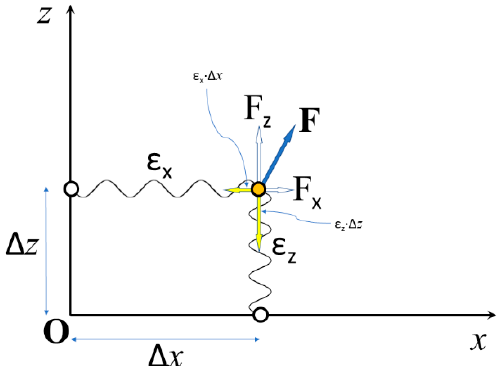
Figure A1. Schematic 2D representation of an elastic element with different stiffness values of ε x and ε z along the x and z directions, respectively. An external force F (blue arrow) applied to the tip of the elastic element (orange circle) is equilibrated by the strains Δ x and Δ z, eliciting the restoring forces (yellow arrows) that balance the component of F along the x (F x ) and z (F z ) directions, respectively (white arrows).